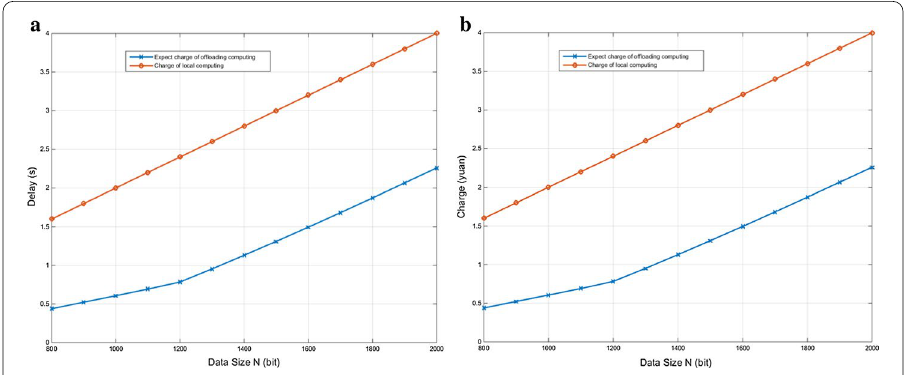
Fig. 2 Charge and delay with different value of data size. a Charge with different value of data size; b Delay with different value of data size